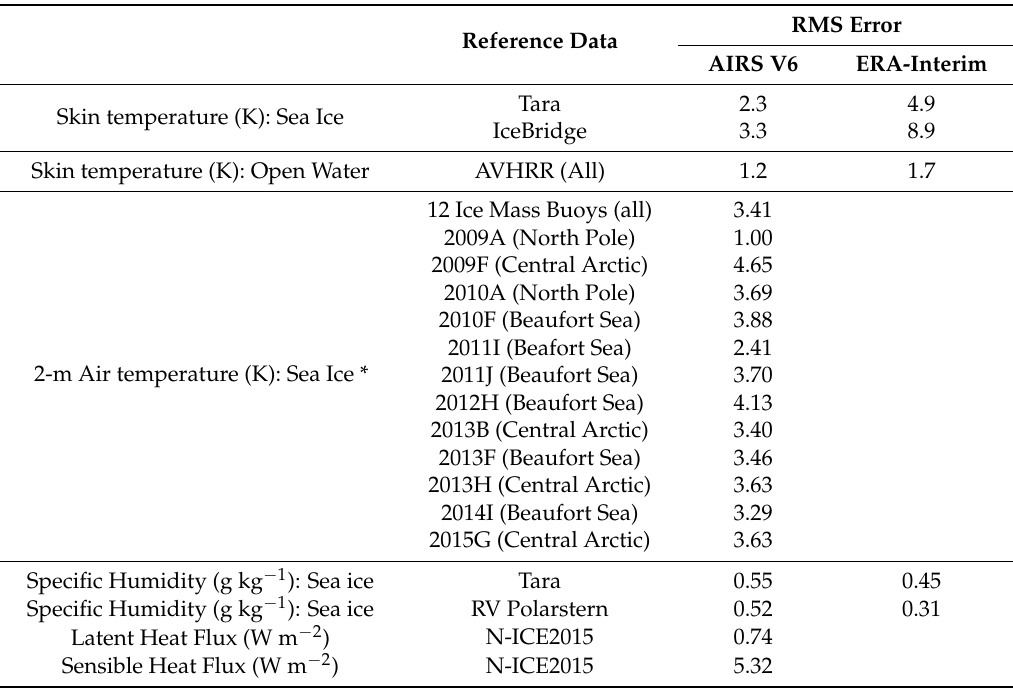
Table 2. Summary of RMS errors in temperature and specific humidity with respect to available in situ and satellite reference